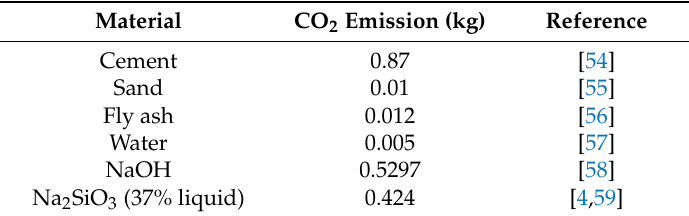
Table 3. One kg of material per CO 2 emission.